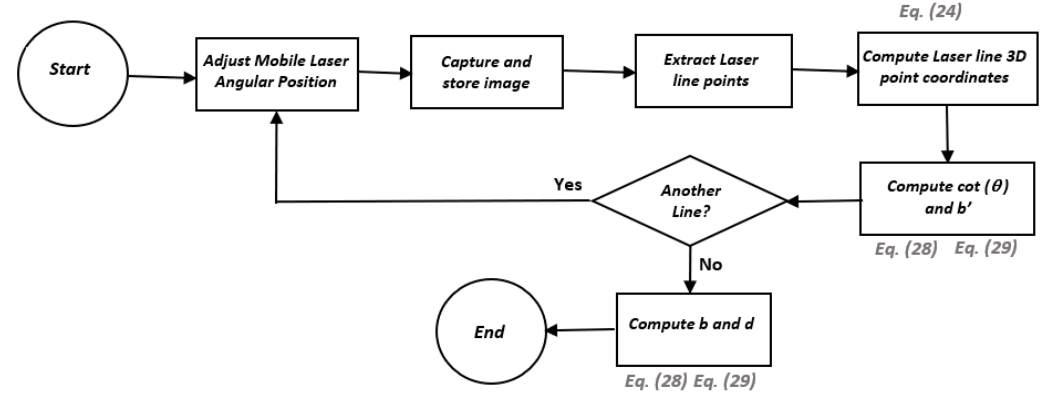
Figure 10. Mobile laser calibration algorithm.